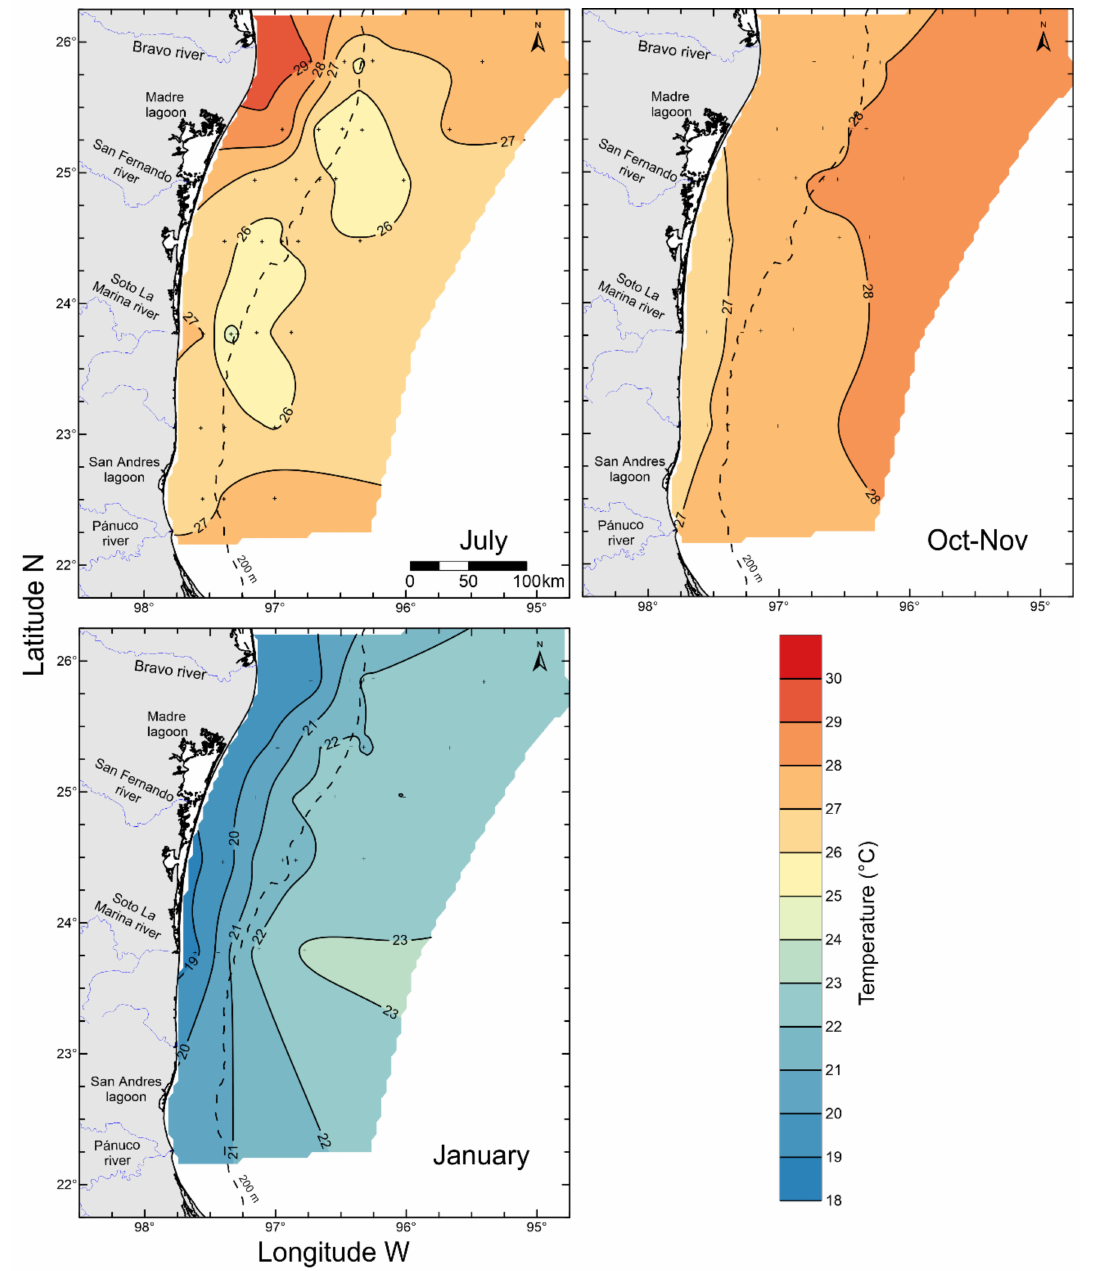
Figure 2. Mean integrated temperature ( ◦ C) in the upper 50 m layer in the western Gulf of